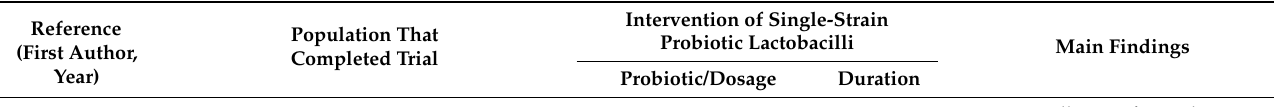
Table 2. Characteristics of 17 studies using single-strain probiotic lactobacilli with the outcome measure of SCORAD